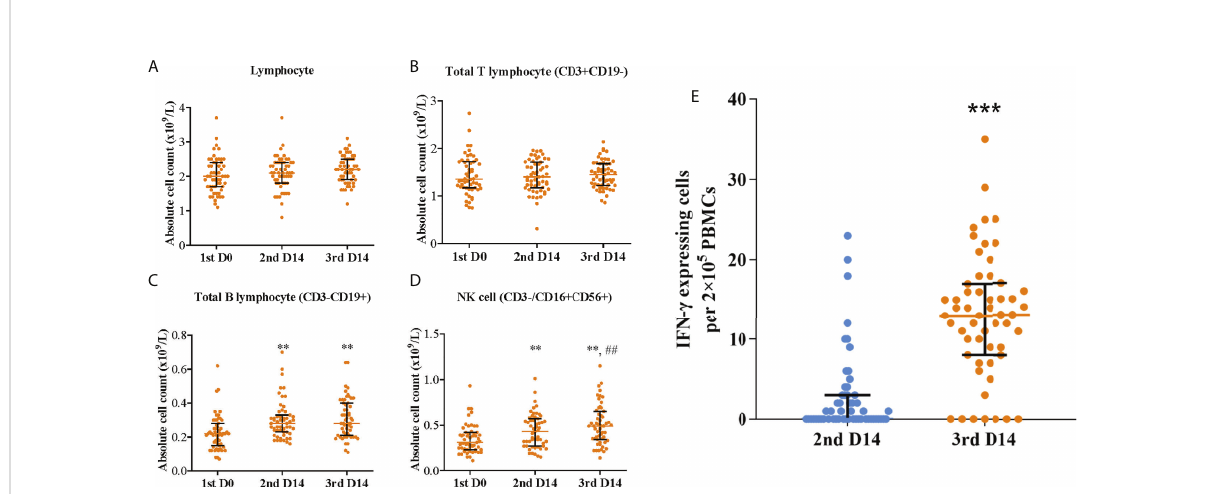
FIGURE 4 Blood lymphocyte subset distribution and speci fi c T-cell responses post primary and booster vaccinations. Absolute count of (A) lymphocyte, (B) total T lymphocyte (CD3+CD19-), (C) total B lymphocyte (CD3-CD19+), and (D) NK cell (CD3-/CD16+CD56+); **p<0.01 as compared with day 0 post the fi rst dose; ## p<0.01 as compared with day 14 post the second dose. (E) Speci fi c T-cell responses; ***p<0.001 as compared with day 14 post the second dose. Colored bars represent medians and black bars represent interquartile ranges. Statistical comparisons between groups were evaluated by Wilcoxon signed-ranked test. 1st D0, day 0 post the fi rst dose; 2nd D14, day 14 post the second dose; 3rd D14, day 14 post the third dose.